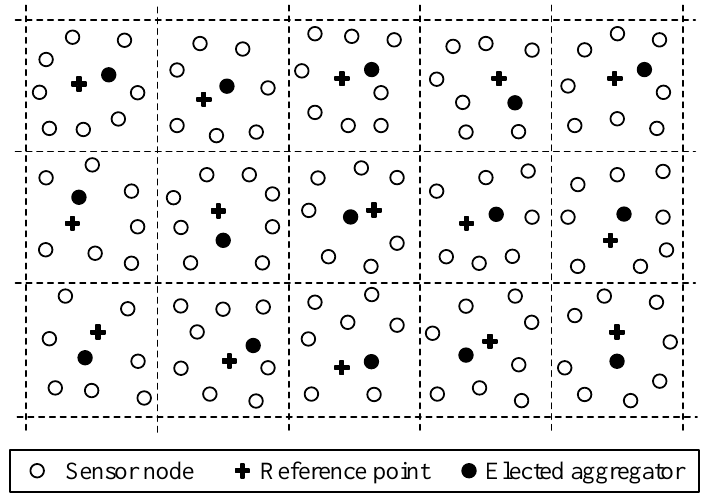
Figure 4. Illustration of the Geographical Clustering in PANEL.